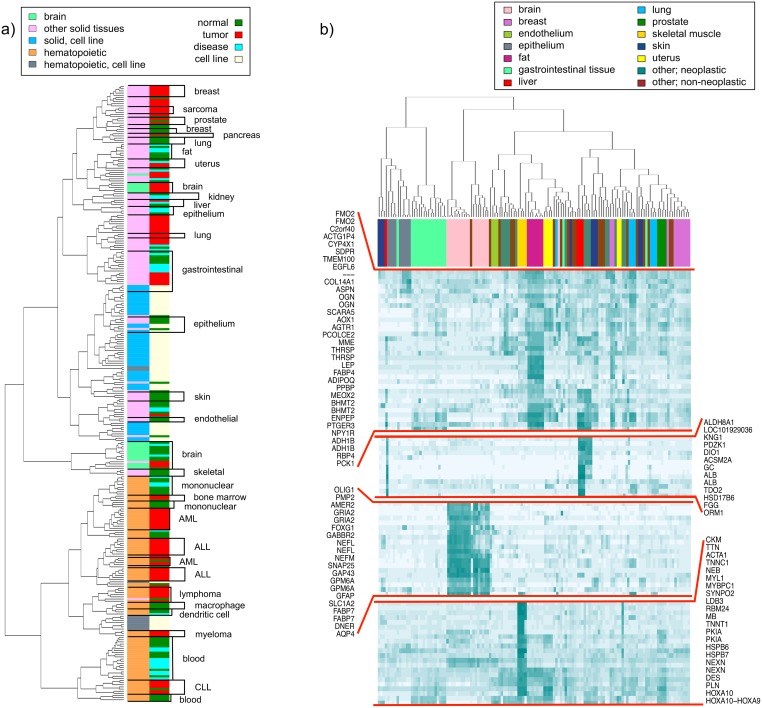
Clustering of biological groups with at least 20 observations.a) Clustering of biological groups using average correlations. Only the 20,000 most variable probesets are accounted for. The groups are recoded by colours to display the largest clusters in the dendrogram. The colour labels on the right hand side specify groups of healthy, cancerous or diseased tissues or cell lines. Illustrative groups of tissues are also highlighted. b) Clustering of biological groups of solid tissues against the 1,000 most variable probesets. Many clusters, identified by visual inspection, include genes overexpressed in one or more tissues of origin. From top to bottom, clusters C.8, C14, C.18 and C.29 display probesets with high activity in adipose tissue, liver, brain and skeletal muscle and heart, respectively.